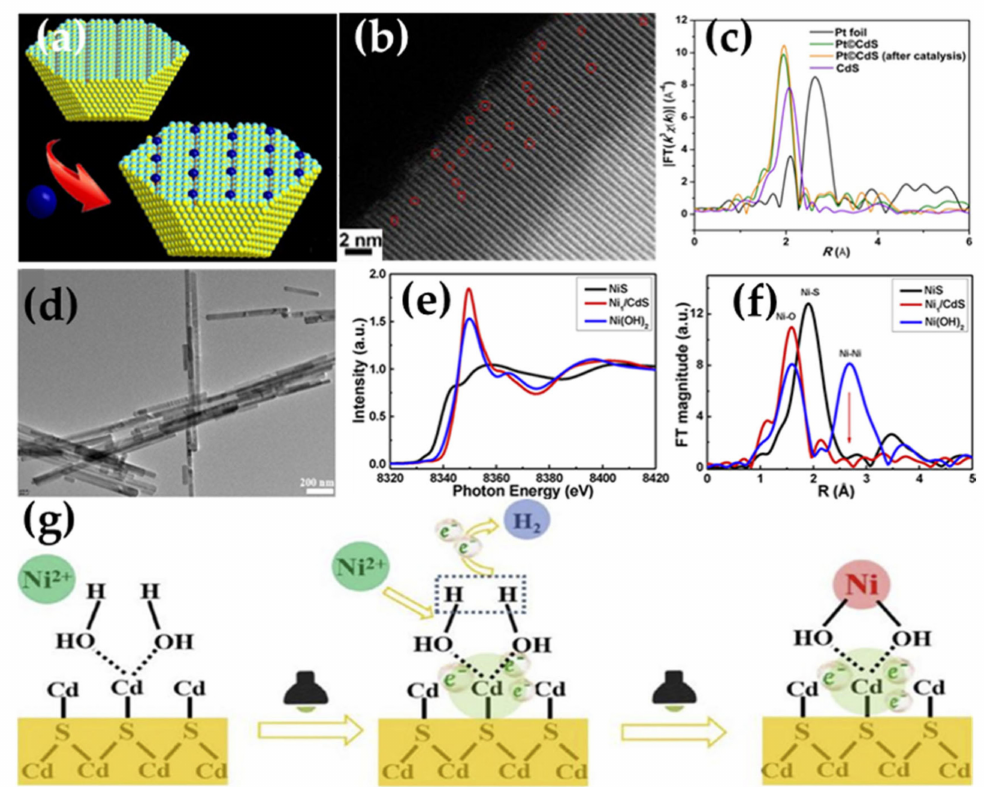
Figure 2. ( a ) The geometric models of isolated platinum atoms decorated on CdS surface with terraces [42]; ( b ) HAADF- STEM image in a spherical-aberration-corrected TEM for Pt©CdS [42]; ( c ) Fourier transform magnitudes of the experimental Pt L 3 -edge EXAFS spectra of samples [42]; ( d ) TEM image of Ni 1 /CdS composite [43]; ( e ) XANES spectra of NiS, Ni 1 /CdS NRs and Ni(OH) 2 reference at Ni K-edge [43]; ( f ) The corresponding Fourier transform curves of EXAFS data [43]; ( g ) Schematic illustration of the preparation of Ni 1 /CdS by photochemical method